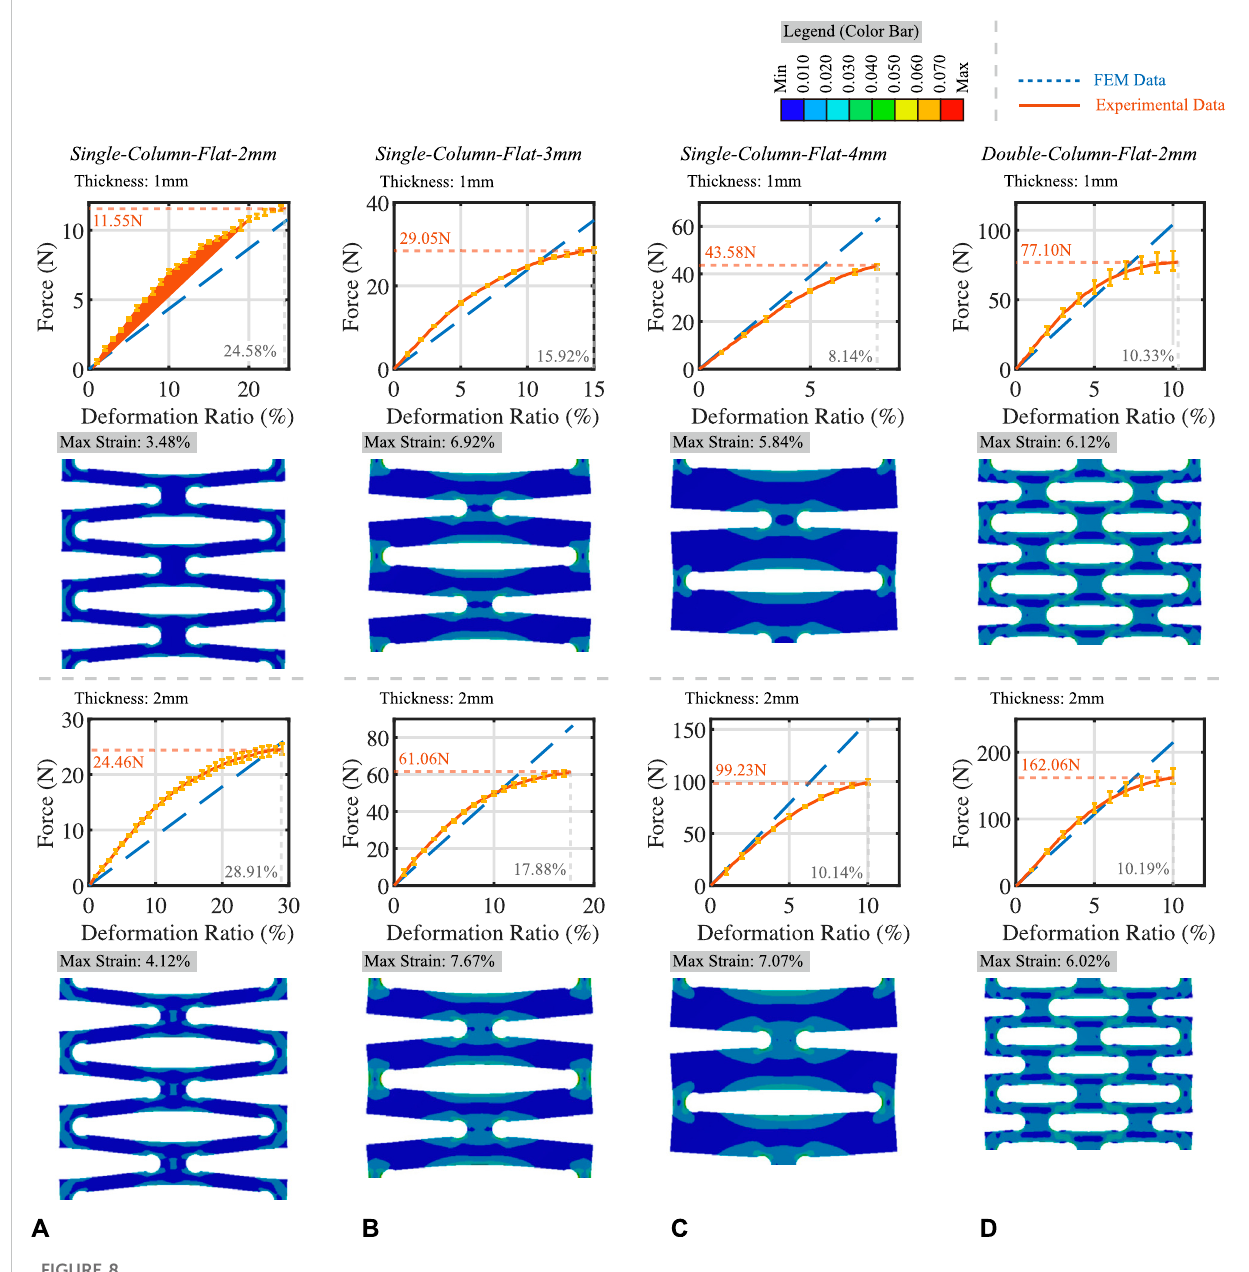
FIGURE 8 Tensile test and FEM results of kirigami-inspired springs. (A) Results of spring with Single-Column-Flat-2mm pattern; (B) Results of spring with Single-Column-Flat-3mm pattern; (C) Results of spring with Single-Column-Flat-4mm pattern; (D) Results of spring with Double-Column-Flat-2mm